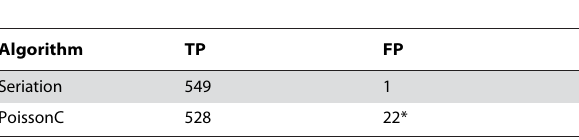
Table 2. Comparative performance of seriation and PoissonC on a simulated SAGE data set with 10 expression